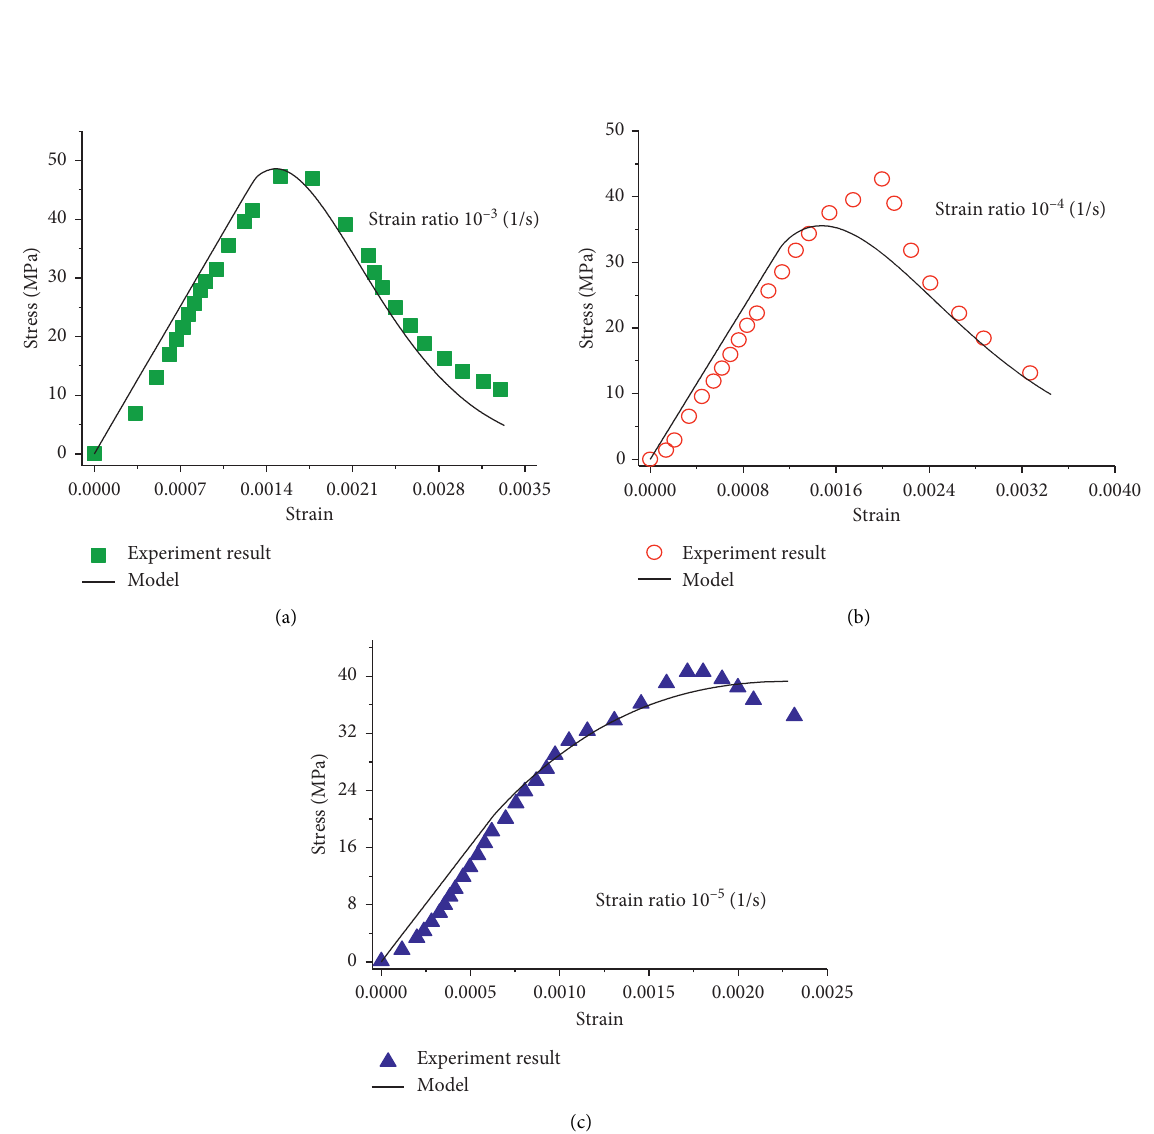
Figure 6: Experimental and model stress-strain curves of concrete under different strain rates.